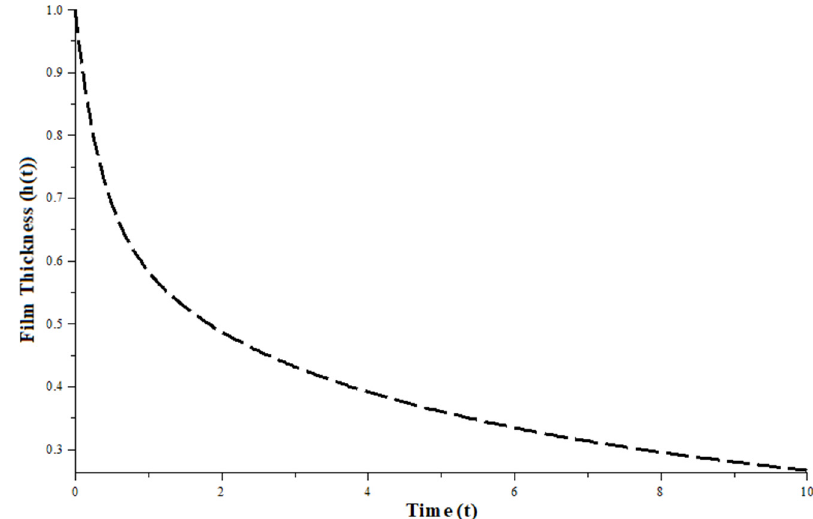
Figure 2. Film thickness.